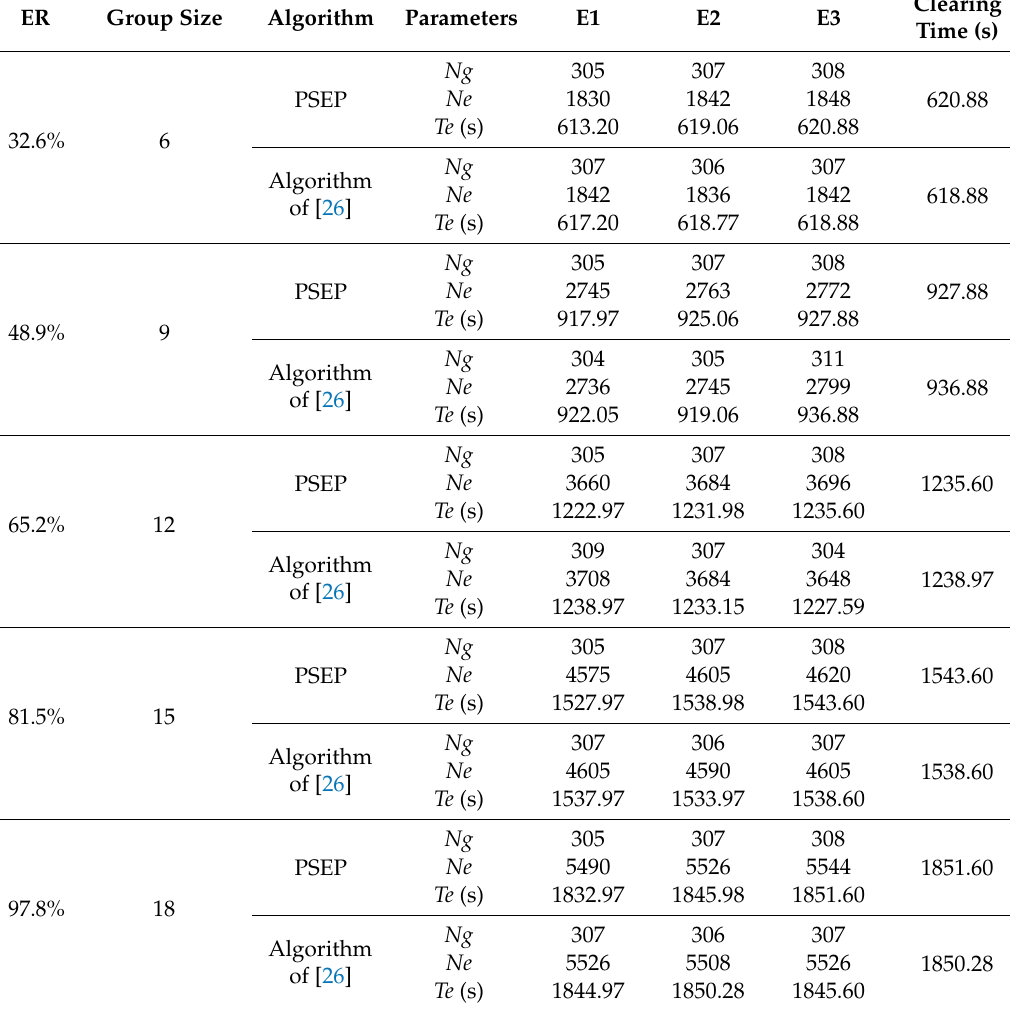
Table 6. The test results when the group size is